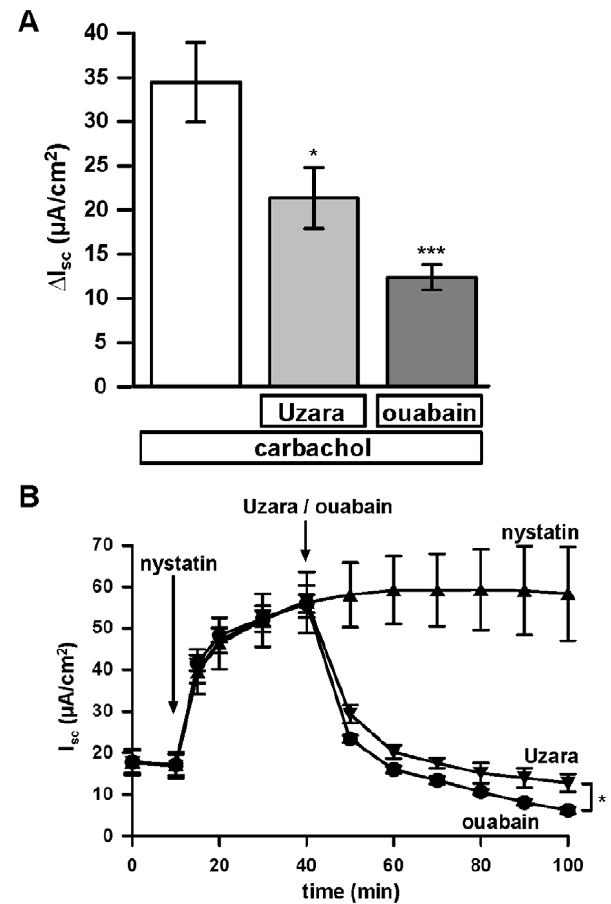
Figure 4. Inhibitory effect of Uzara and ouabain on the nystatin-induced I SC rise in HT-29/B6 cells. The effects of Uzara and ouabain, a specific inhibitor of the Na + /K + -ATPase, were analyzed on the rise in I SC induced by nystatin. Nystatin (15 m g/ml) which perforates cell membranes was applied to the mucosal compartment 30 min prior to basolateral addition of 50 m g/ml Uzara or 100 m M ouabain. I SC was measured in HT-29/B6 cell monolayers mounted in Ussing chambers. The nystatin-induced rise in I SC was diminished by Uzara as well as by ouabain. Data are expressed as mean 6 s.e.m.